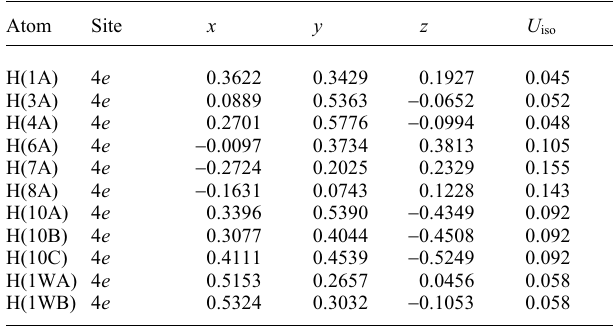
Table 2. Atomic coordinates and displacement parameters (in Å 2 )